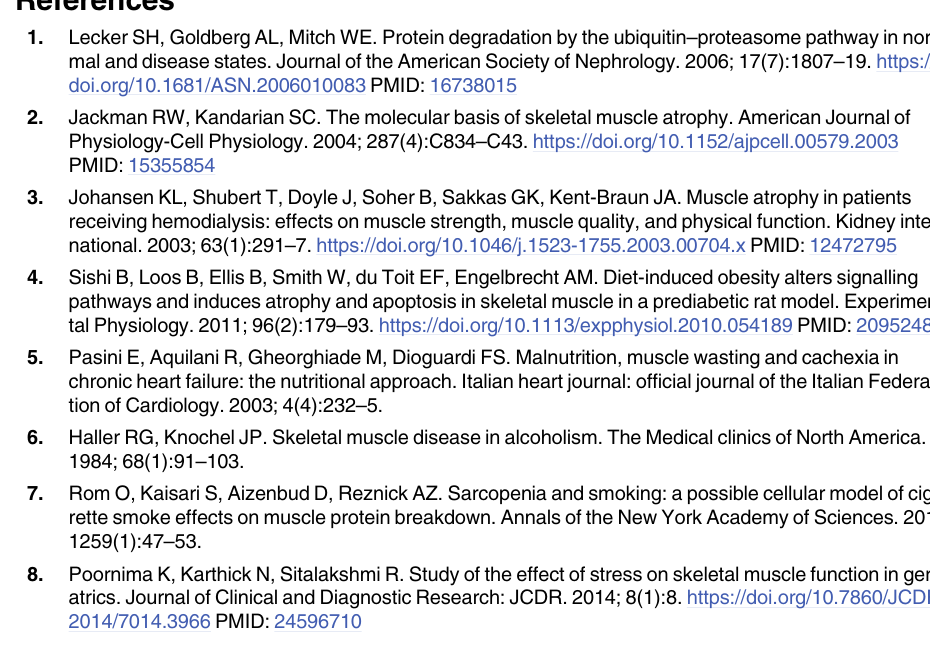
S1 Fig. Female CRF-OE mice exhibited decreased muscle function and mass. (a and b) Four-limb grip strength and (c and d) wire hanging fall latency normalized to body weight. (e) Soleus, rectus femoris, and gastrocnemius muscle weights. � P < 0.05 and �� P < 0.01 compared to WT mice. Values represent the mean ± s.e.m (n = 7). (TIF) S2 Fig. Glucocorticoid receptor (GR) levels of gastrocnemius muscles were higher than those of soleus muscles in CRF-OE mice. Western blot analysis of GR levels in soleus and gastrocnemius muscles of CRF-OE mice. Values represent the mean ± s.e.m. of three experi- ments. In each experiment, sample was pooled from 5–6 mice in each group. (TIF) S1 Raw images.